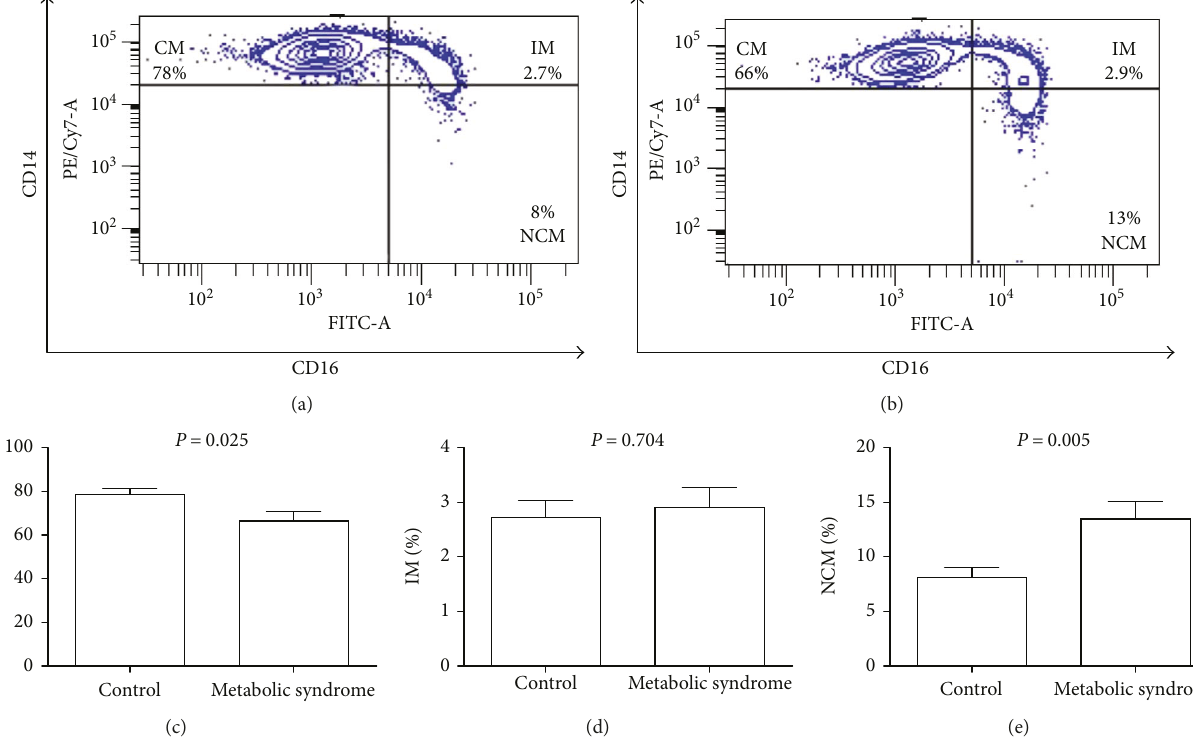
Figure 1: Percentage of classical, intermediate, and nonclassical monocytes in metabolic syndrome patients and control subjects. Representative fl ow cytometry dot plots showing the percentage of classical (CM), intermediate (IM), and nonclassical monocytes (NCM) in control subjects (a) and patients with metabolic syndrome (b). The CM percentage is signi fi cantly decreased in metabolic syndrome patients as compared to controls (c). The IM percentage showed no signi fi cant di ff erences between metabolic syndrome patients and controls (d). The NCM percentage is signi fi cantly increased in metabolic syndrome patients as compared to controls (e). For gating strategy, white blood cells were fi rstly gated for singlets on a FSC-H/FSC-A density plot. Then, lymphocyte, granulocyte, and monocyte populations were gated on a FSC-A/SSC-A plot. On the monocyte gate, living cells were further gated using the Live/Dead Aqua stain. Living monocytes were then gated to determine CD14- and CD16-positive expression and identify monocyte subpopulations as follows: CD14 high CD16 − , classical monocytes; CD14 high CD16 + , intermediate monocytes; and CD14 low CD16 + , nonclassical monocytes. In panels (c) – (e), data are expressed as mean ± standard deviation . Signi fi cant di ff erences were estimated by means of performing Student ’ s t - test. Di ff erences were considered signi fi cant when P < 0 05 . Diagnosis of metabolic syndrome was performed according to the ATP III criteria, when three of fi ve of the following factors were present: central obesity denoted by a waist circumference greater than 80 cm in women and 90cm in men, hypertriglyceridemia (circulating triglyceride levels > 150mg/dL ), decreased serum values of HDL-cholesterol (serum HDL < 40mg/dL in men and 50 mg/dL in women), blood pressure higher than 120/80 mmHg, and hyperglycemia (fasting blood glucose > 100mg/dL (66.46 ± 4.5 versus 78.62 ± 2.68, resp.) (Figure 1(c)). The IM subpopulation (CD14 high CD16 + ) did not show any signi fi - cant di ff erence between controls and metabolic syndrome subjects (2.72 ± 0.30 versus 2.90 ± 0.36, resp.) (Figure 1(d)). In contrast, the percentage of NCM expressing CD16 and low CD14 levels exhibited a signi fi cant 65% increase in (13.47 ± 1.59 versus 8.12 ± 0.89, resp.) (Figure 1(e)).